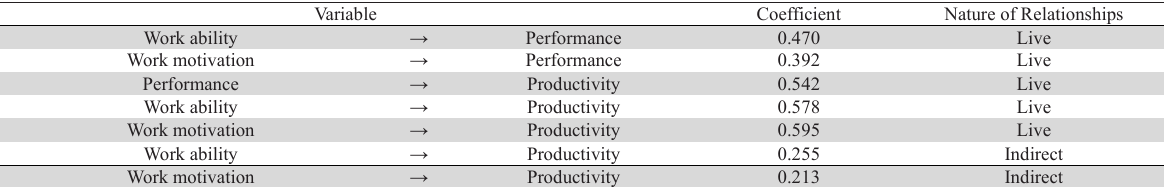
Relations Between Variables Variable Coefficient Nature of Relationships Work